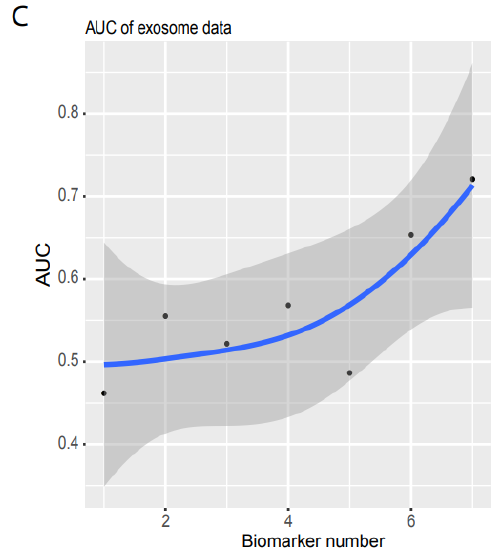
Figure 3. Independent validation. ( A ) Summary of AUC vs. biomarker number validated by validation data set 1 (ArrayExpress, #E-MTAB-5423, Figure 1). 39 biomarkers reached 78.77% of AUC. ( B ) ROC of validation data set 2 (exosome data). Seven biomarkers reached 0.721 of AUC. ( C ) Summary of AUC vs. biomarkers number validated by validation data set2. Gray area denotes confidence interval.